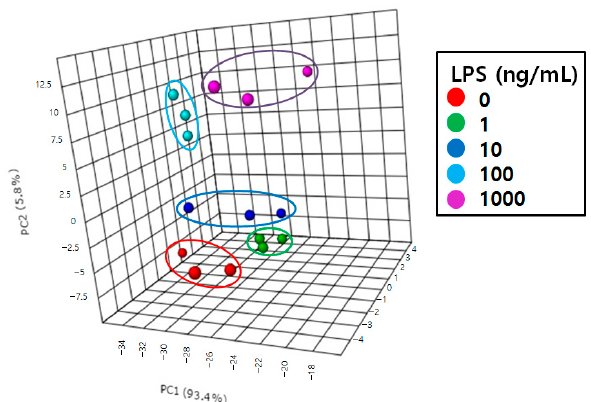
Figure 5. Principal component analysis (PCA) score plot of RAW264.7 cells treated with 0, 1, 10, 100, and 1000 ng/mL LPS.